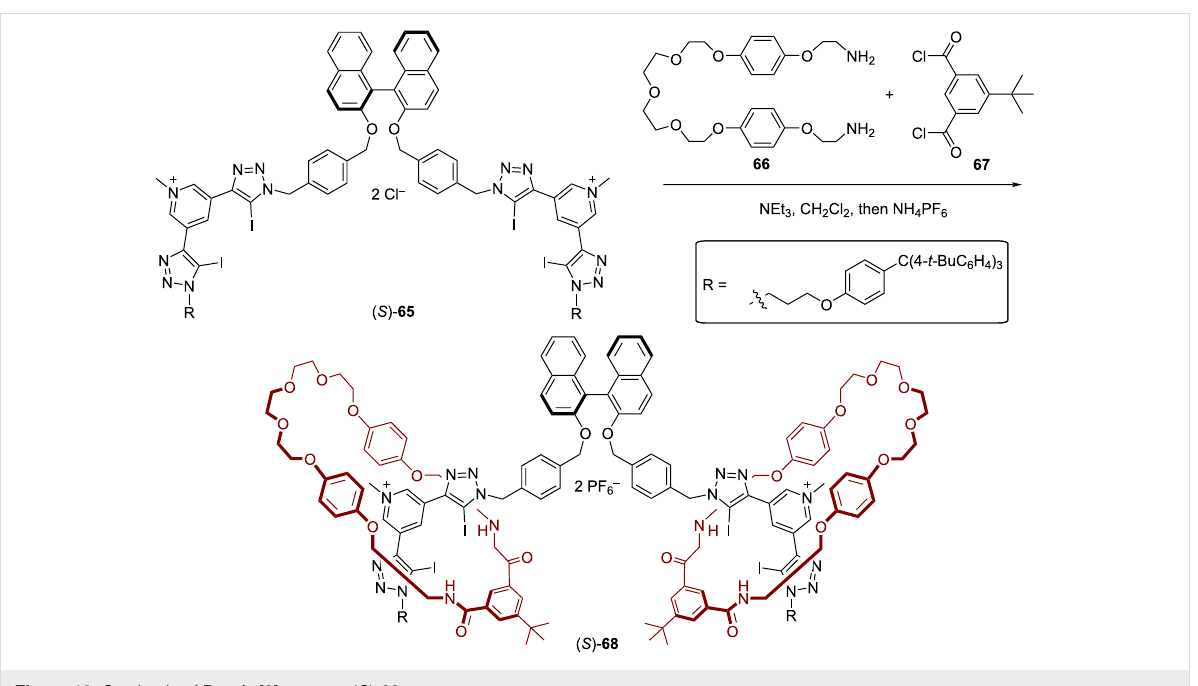
Figure 18: Synthesis of Beer´s [3]rotaxane ( S )- 68